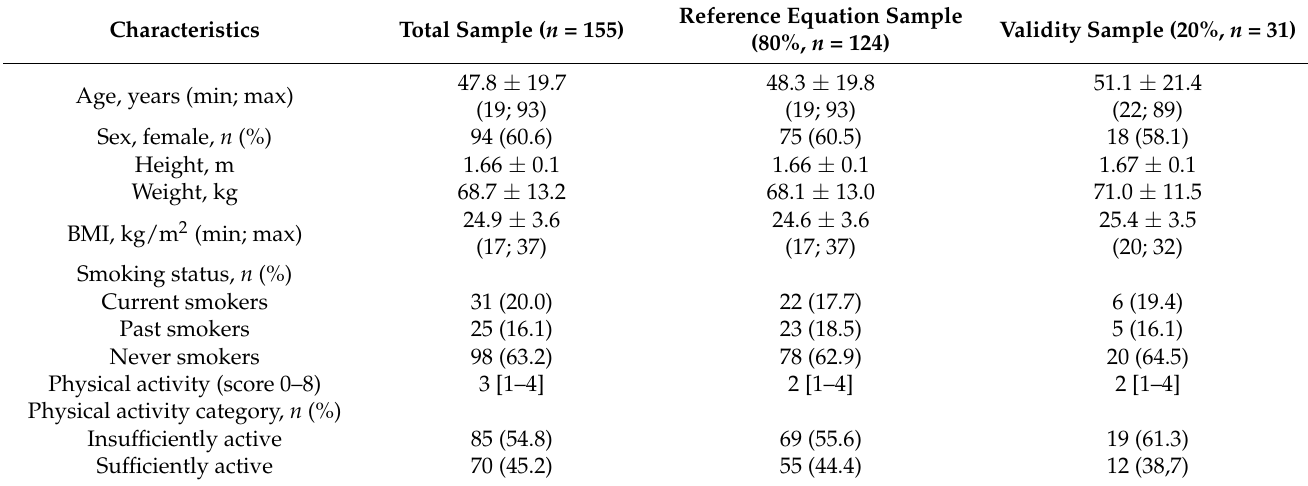
Table 1. Characteristics of